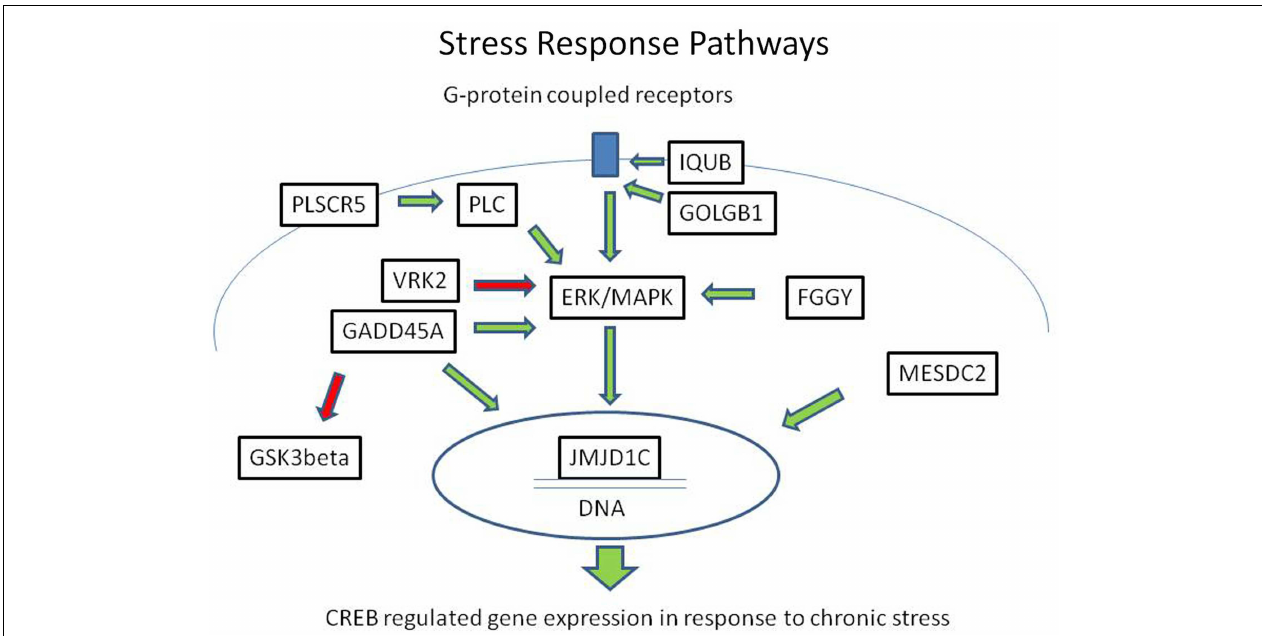
membrane to the nucleus. IQUB and GOLGB1 are involved in G-protein coupled receptor recycling. FGGY,VRK2, GADD45A, and PLSCR proteins influence signal transduction through the ERK/MAPK messenger cascade. MESDC2 and JMJD1C influence CREB-regulated gene expression in the nucleus. Direct physical interaction has been reported between GADD45A and JMJD1C.These second messenger systems are also the target of lithium and valproic acid, which are commonly used to treat bipolar disorder. Green arrows indicate activating influences and red arrows indicate inhibiting